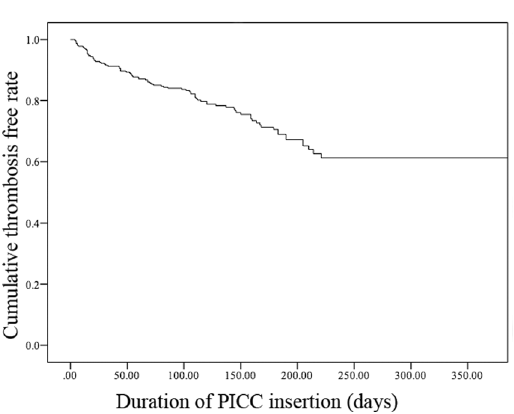
Figure 1. Cumulative thrombosis free rate of the duration of PICC insertion.